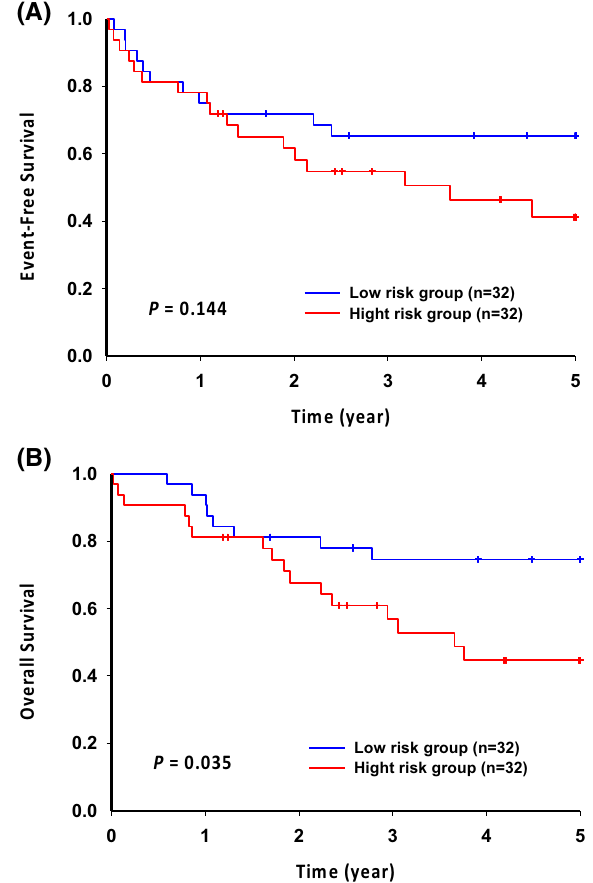
Figure 4. Event-free survival ( A ) and overall survival ( B ) of patients with T-cell acute lymphoblastic leukemia, stratified by genetic lesions in NOTCH1 , FBWX7 , RAS, and PTEN. Patients with NOTCH1 / FBXW7 mutations and RAS / PTEN germline were considered to be a low risk group (n = 32) and the others were classified as a high- risk group (n =